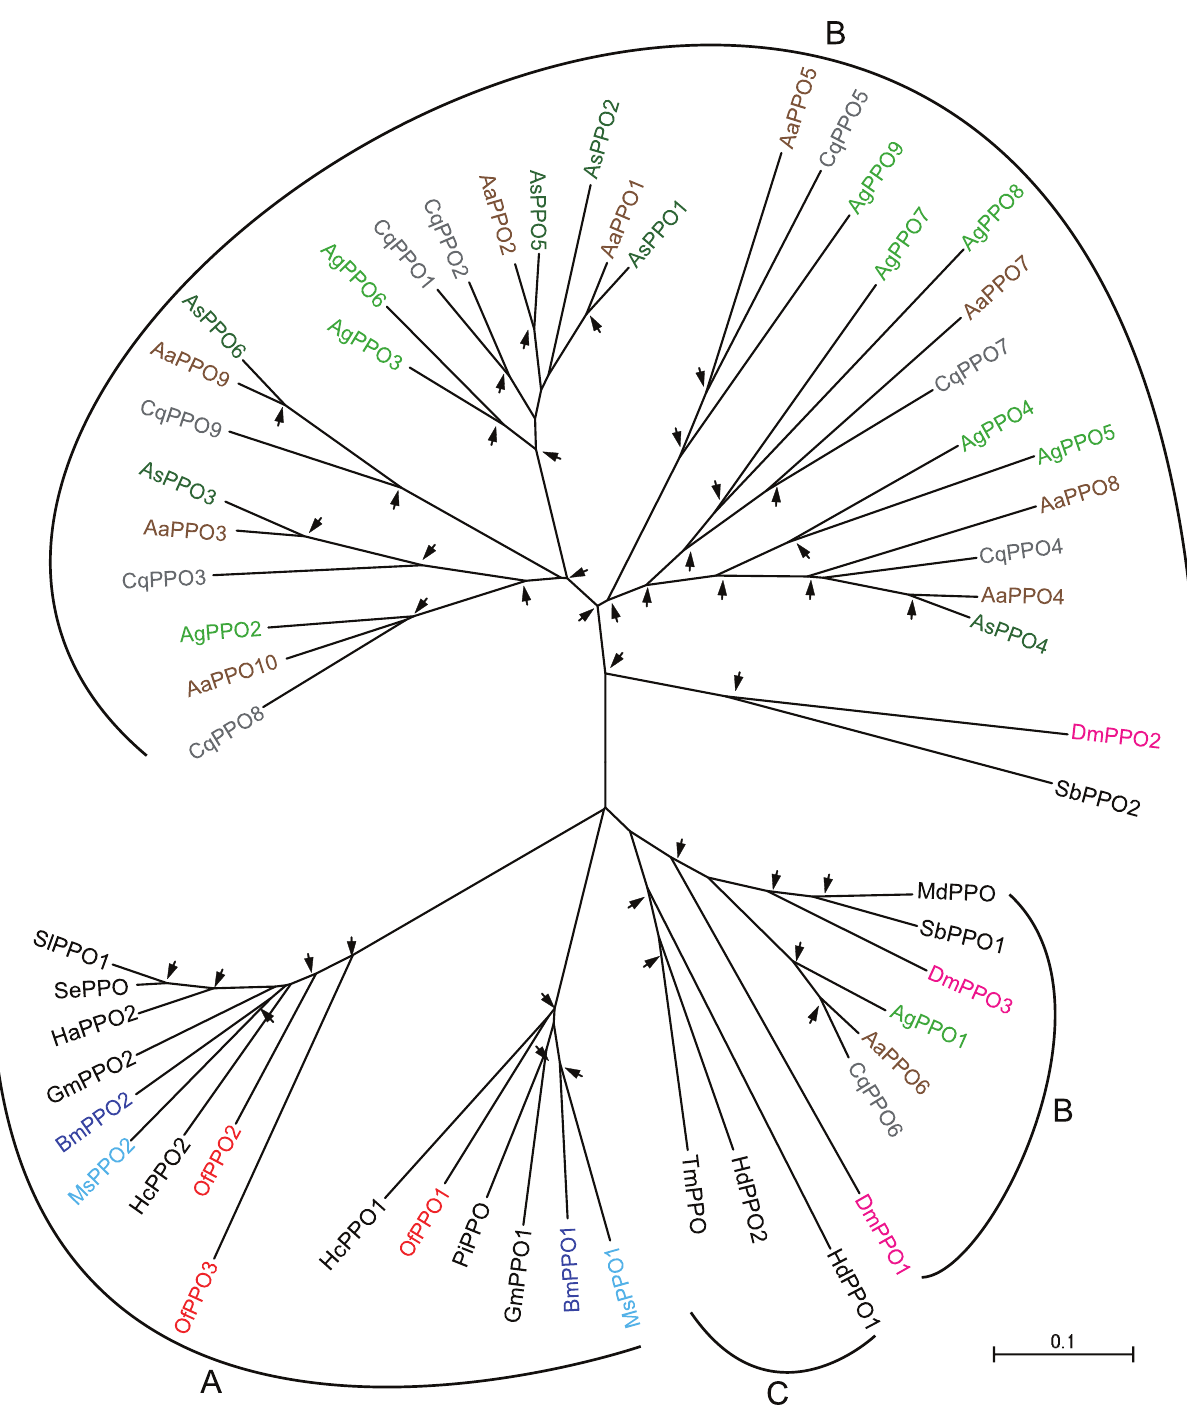
Figure 8. Phylogenetic analysis of prophenoloxidases (PPOs). The used amino acid sequences of 58 PPOs are from Ostrinia (Of), Drosophila (Dm), Anopheles (Ag), Aedes (Aa), Culex (Cq), Bombyx (Bm), Manduca (Ms), Sarcophaga bullata (Sb), Musca domestica (Md), Armigeres subalbatus (As), Galleria mellonella (Gm), Helicoverpa armigera (Ha), Hyphantria cunea (Hc), Holotrichia diomphalia (Hd), Plodia interpunctella (Pi), Spodoptera exigua (Se), Spodoptera litura (Sl), Tenebrio molitor (Tm). The 1:1 and 1:1:1 orthologs including OfPPOs are present in the tree. A-C denotes the cluster specific for lepidopteran, dipteran, and coleopteran PPOs, respectively. For explanation of the arrows see Fig. 6. doi:10.1371/journal.pone.0086436.g008 PCR analysis of OfPPO2 expression revealed that the mRNA level of OfPPO2 was significantly increased after the injection of B. bassiana conidia (Figure 2).